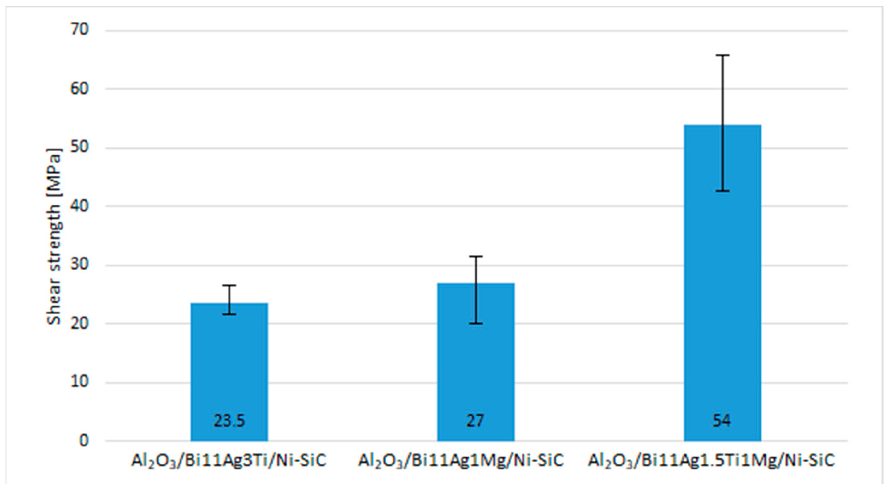
Figure 20. Shear strength measurement of soldered joints.